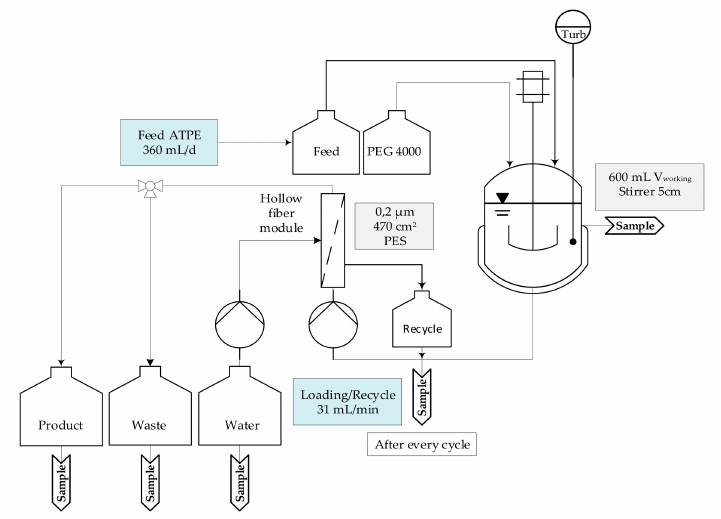
Figure 4. Experimental set-up of precipitation unit using a hollow fiber module to capture mAb (monoclonal antibody) precipitate and subsequently using IEX (ion exchange chromatography) bu ff er for dissolution and preparation to the next downstream purification step. PES (polyethersulfone), ATPE (aqueous two-phase extraction), PEG (polyethylene glycol), Turb